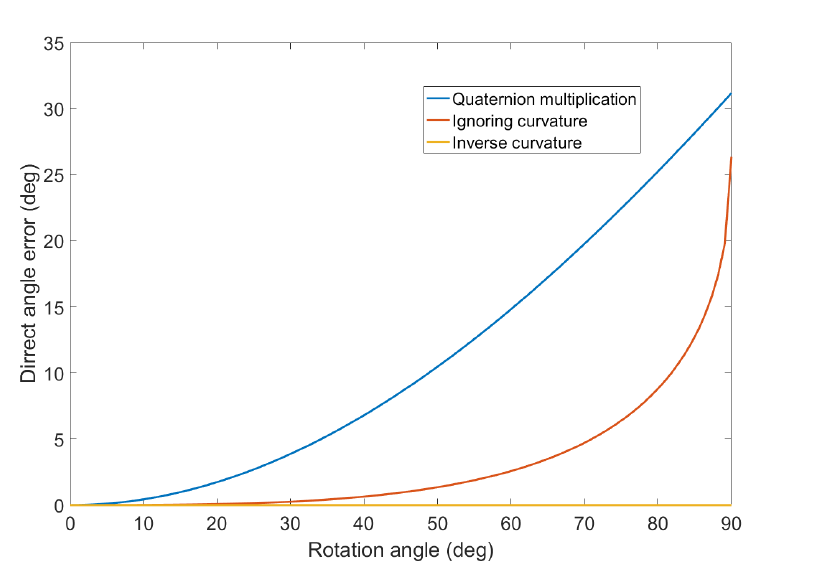
Figure 2. Accuracy of quaternion fusion of two rotations of perpendicular directions with the same value of the rotation angle for the quaternion multiplication (blue), the proposed method with inverse quadrature (24) (yellow), and the simplified method (25) ignoring the curvature (red). The error is computed as a deviation from the numerical solution with billion